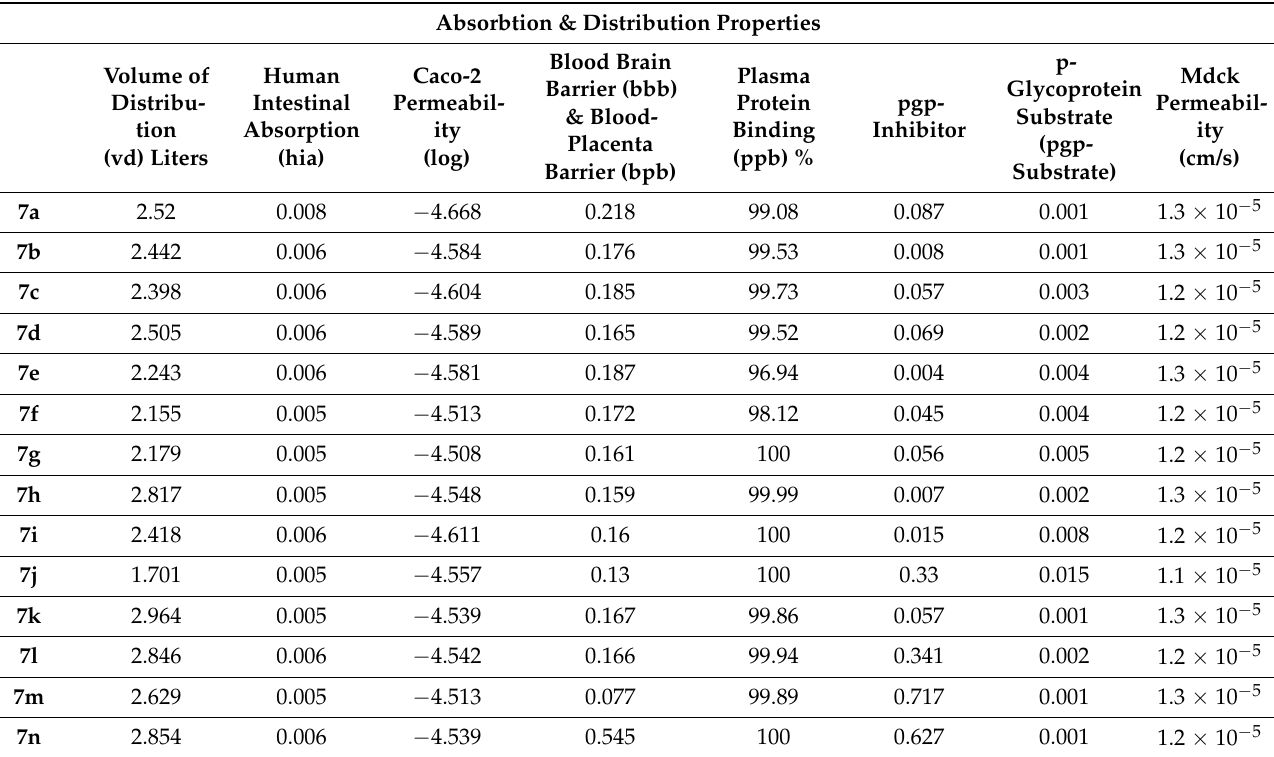
Table 7. Absorption and distribution properties of selected compounds. Absorbtion & Distribution